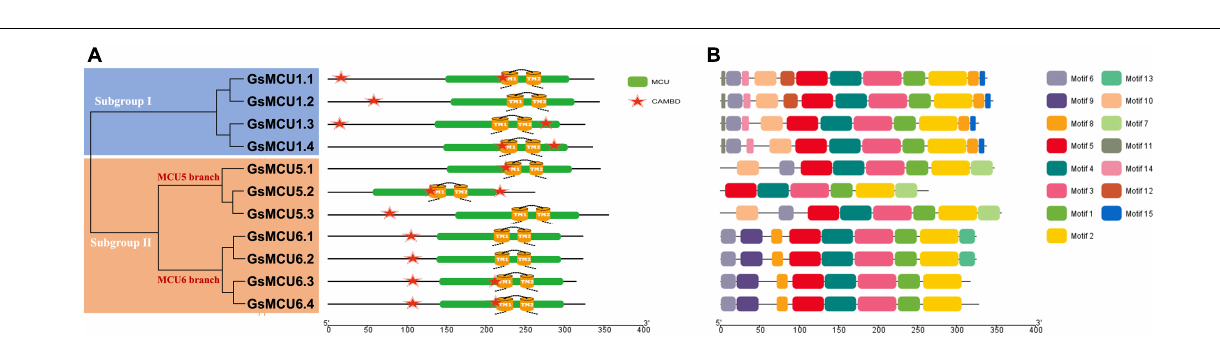
FIGURE 4 | Functional domains and conserved motifs of GsMCU proteins. Functional domains (A) and conserved motifs (B) are indicated by green boxes and different colored boxes represent different motifs. The five-pointed stars represent the calmodulin-binding sites in the GsMCU proteins. Protein domains and conserved motifs were predicted using a CDD search and